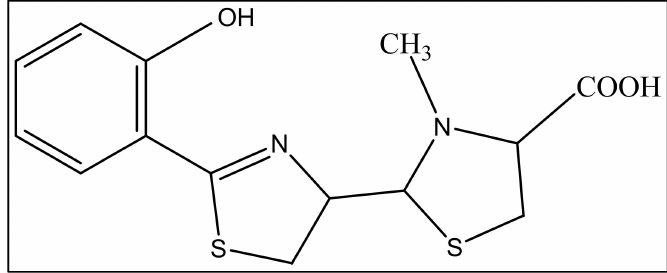
Figure 4. The structure of